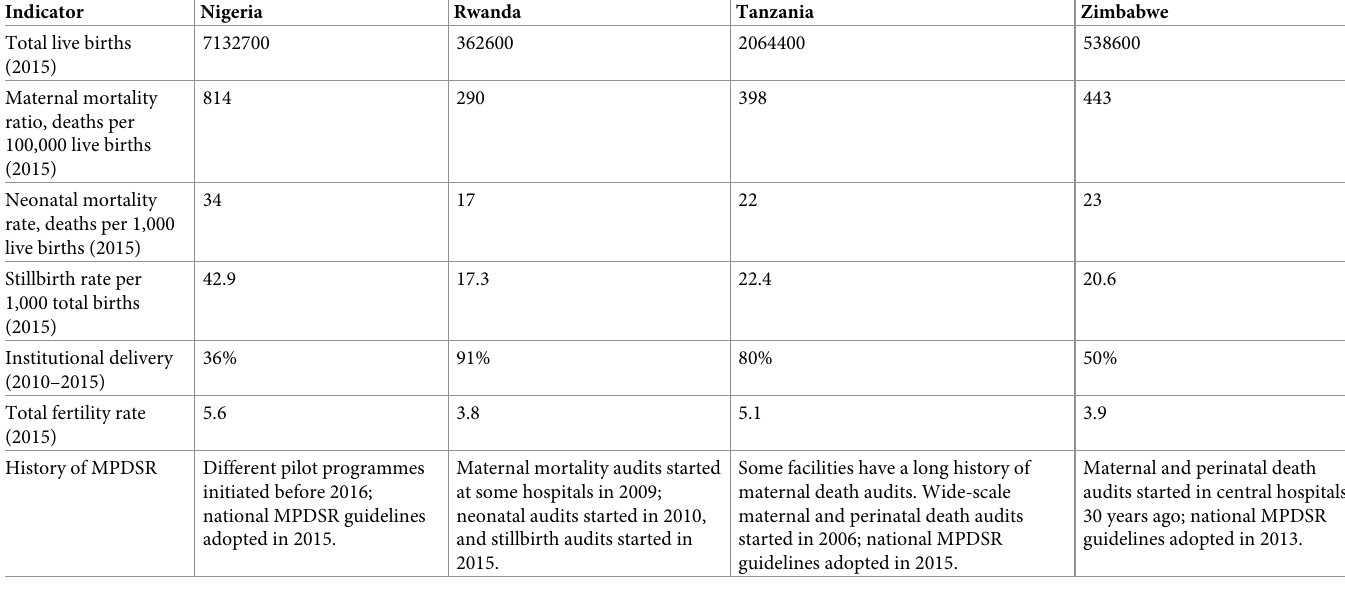
Table 1. Selection of maternal and newborn health information for the four countries. Indicator